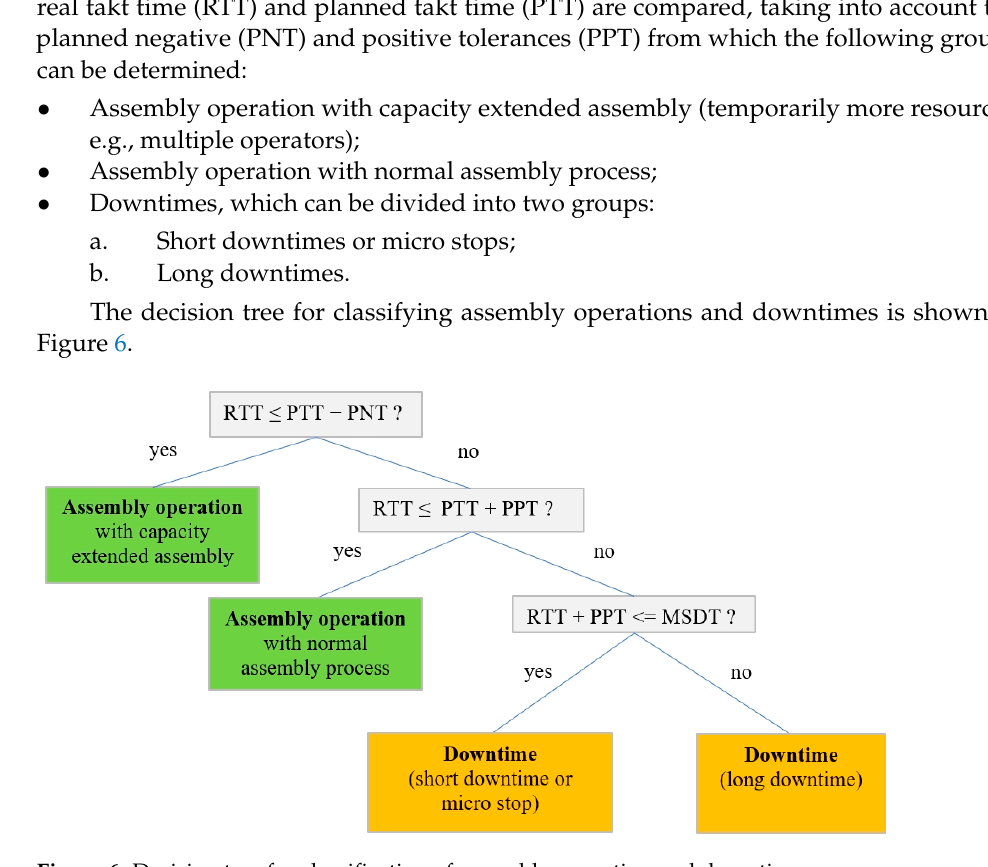
Figure 7. Decision tree for classification of different downtimes. These two decision trees serve as the basis for the OEE prediction presented in the next section. 4.3. Target ‐ Oriented OEE Prediction The aim of the target ‐ oriented OEE prediction model is to predict the OEE value of the next few weeks based on the decision trees presented earlier, taking into account the OEE values of the recent past with different weights, while also taking into account the planned OEE target. The target ‐ oriented OEE prediction model is shown in Figure 8.